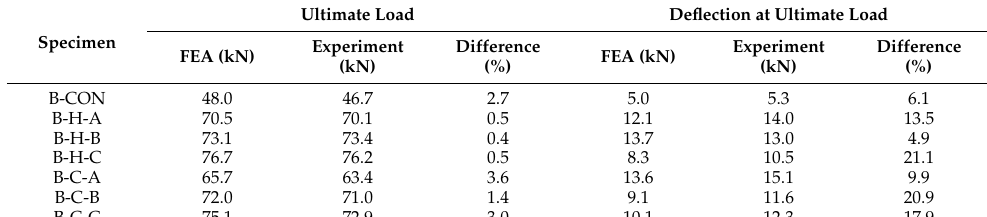
Table 9. FEA predicted vs. experimental results.